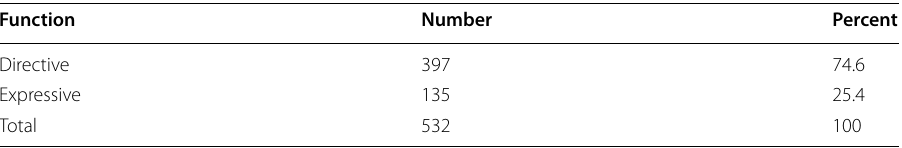
Table 1 Feedback distribution based on speech act functions Function